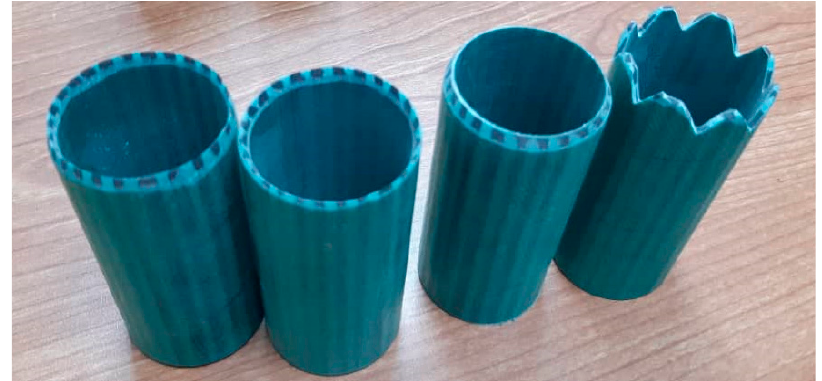
Figure 4. The different chamfered samples as the trigger